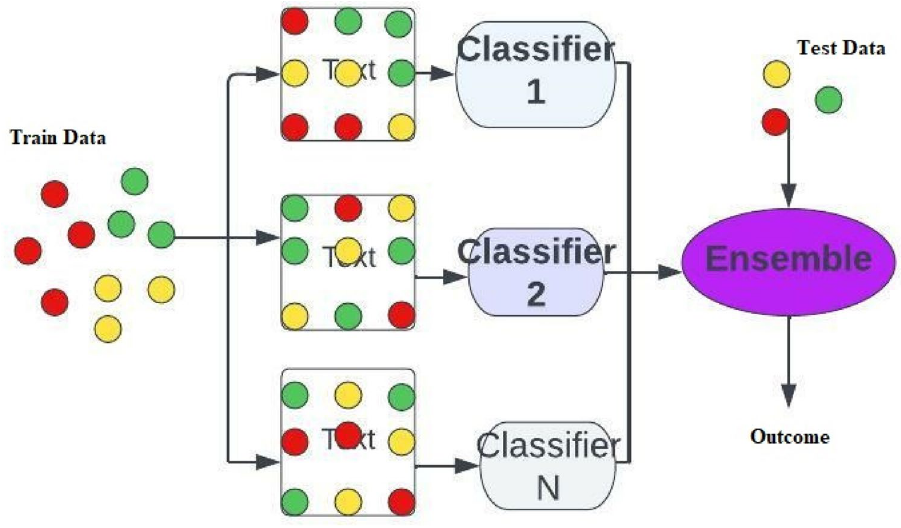
Fig. 3 Presentation of bagging technique for classification problems